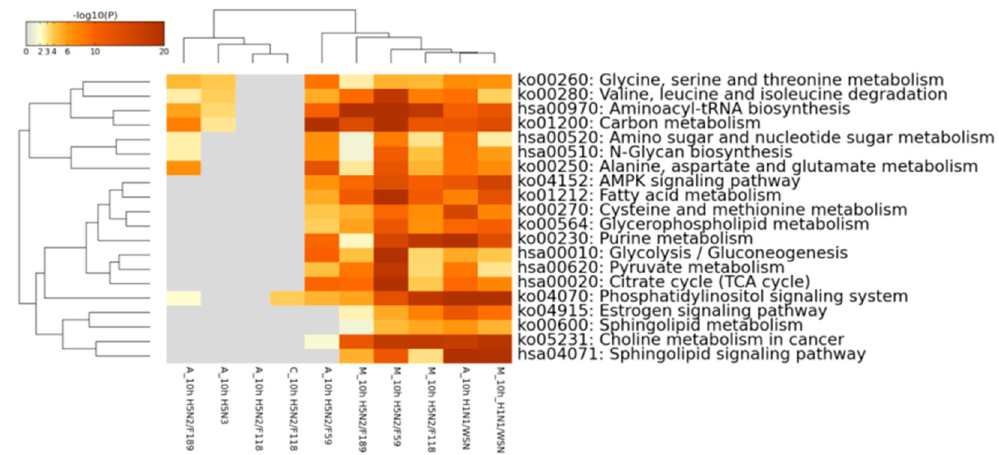
Figure 5. DEGs and pathways involved in metabolic pathways. ( A ) Hierarchical clustering and heat map of the DEGs involved in metabolic pathways; ( B ) top 20 up-regulated metabolic pathways; ( C ) top 20 down-regulated metabolic pathways.